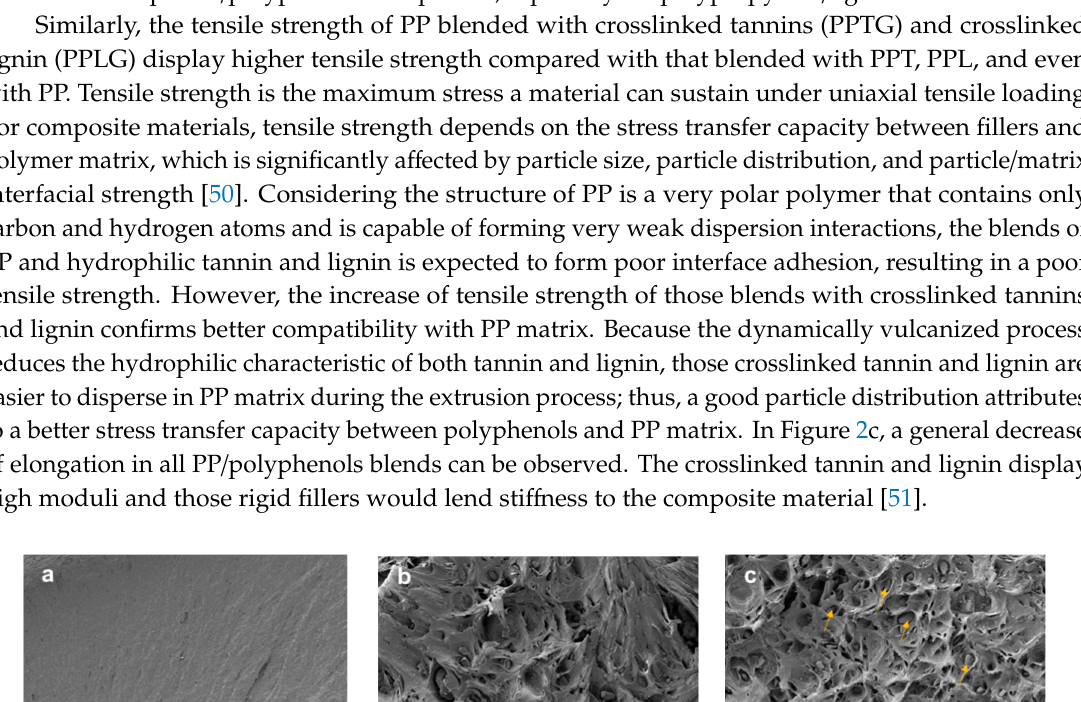
Figure 4. The crystallinity index of PP, PP/polyphenol blends, and PP/crosslinked polyphenol blends. The effects of native and crosslinked tannin/lignin on the thermal behavior of the PP matrix were determined by thermogravimetric analyses in an air atmosphere. Their weight loss as a function of temperature and derivative thermo-gravimetric (DTG) data are plotted in Figure 5. All samples degraded in a one-step process, from 220 to 410 °C, as can be concluded by the presence of only one peak in the DTG curves. Pure PP degraded completely without any char while the PP/polyphenol